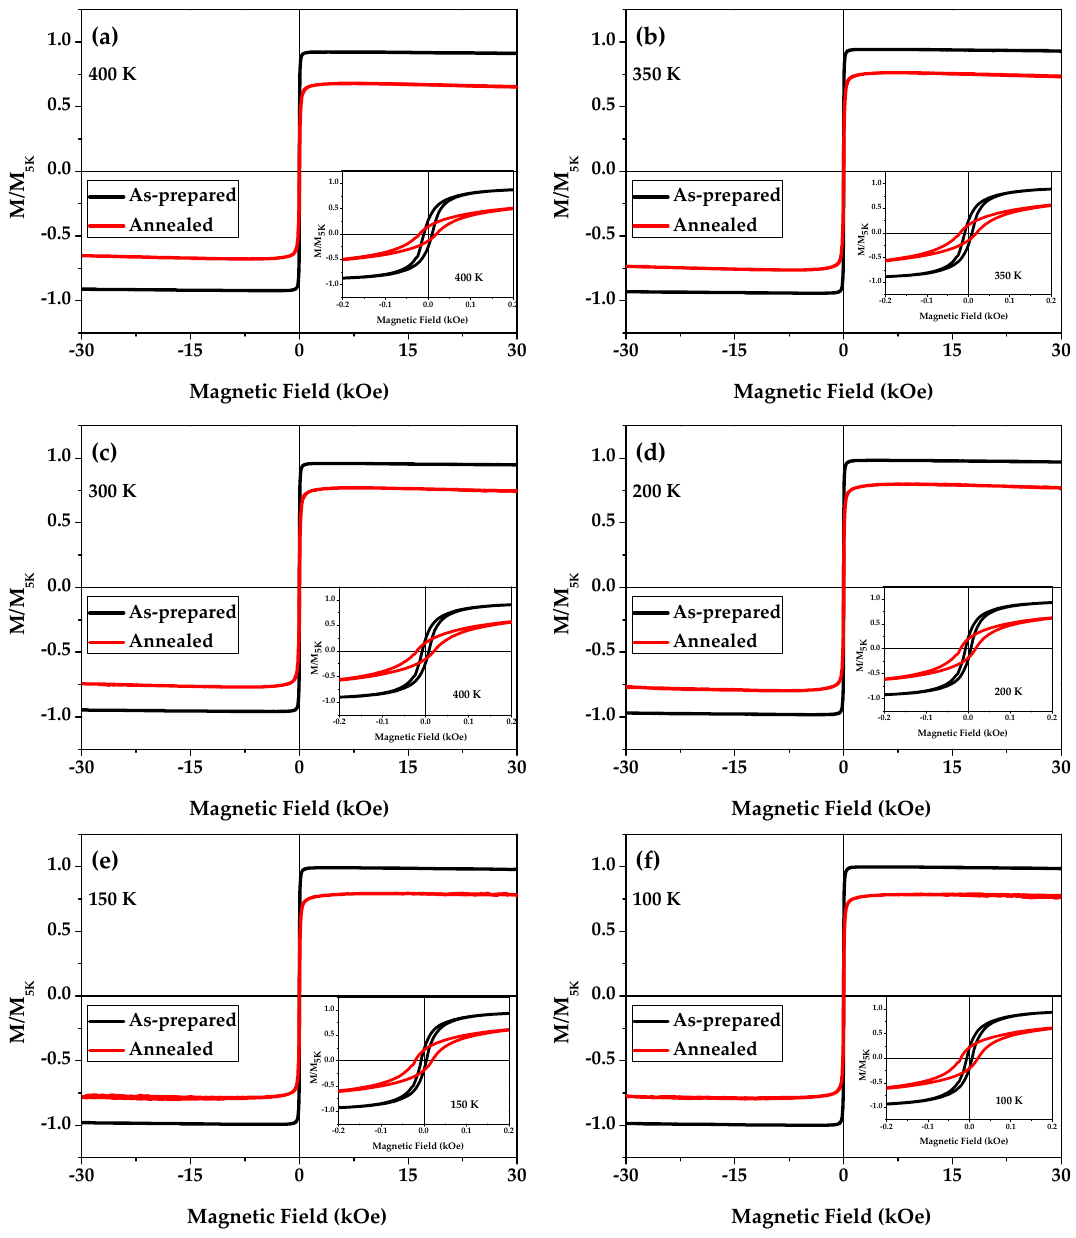
Figure 3. Co 2 MnSi glass-coated microwire magnetization curves (M/M 5K ) for as-prepared samples (black loops) and samples annealed at 1023 K for 2 h (red loops) were measured under a maximum field of 30 kOe and at different temperatures (from 400 K to 100 K). The inset indicates the loops with low scale of the applied magnetic field.